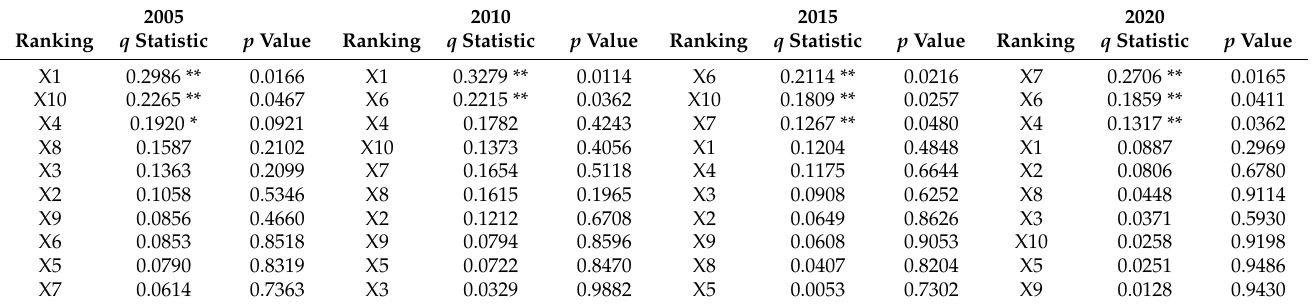
Table 5. Results of single factor detection of the spatial-temporal evolution of the multifunctional coupling coordination degree of cultivated land in the study areas in 2005, 2010, 2015, and